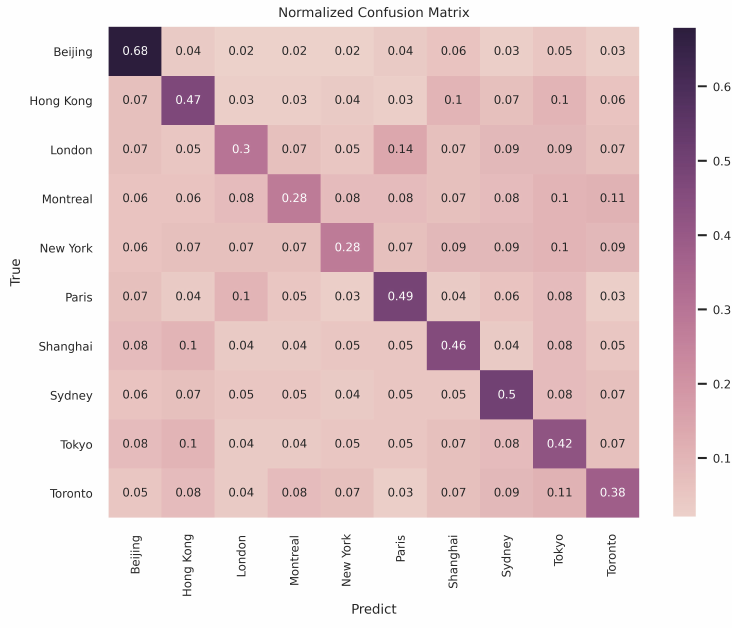
Figure 3. Normalized confusion matrix of classification